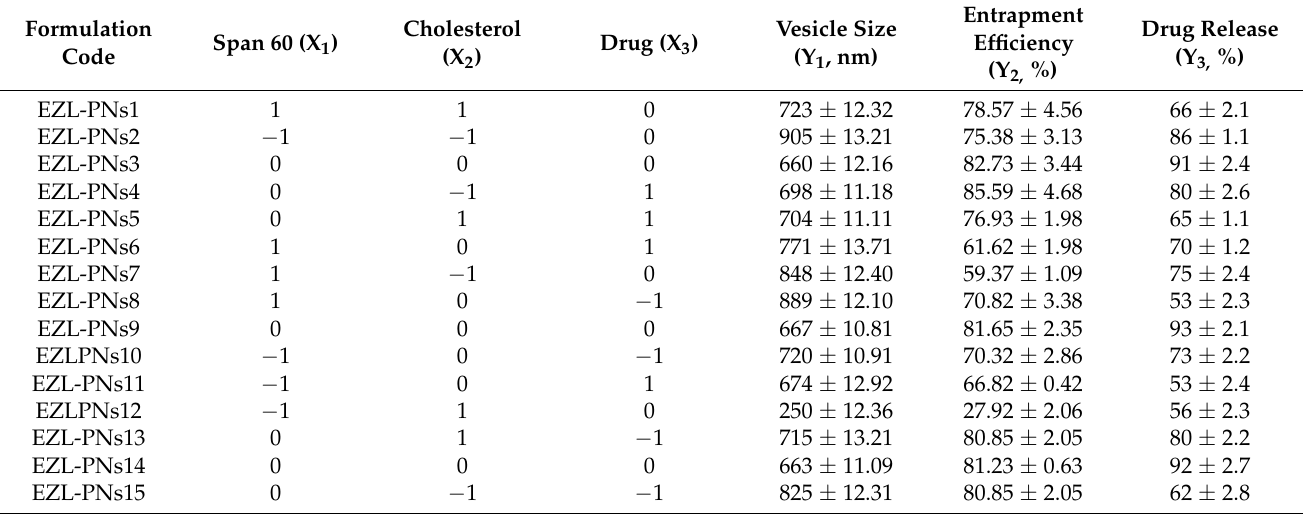
Table 2. Composition of esomeprazole loaded maltodextrin-based proniosomes